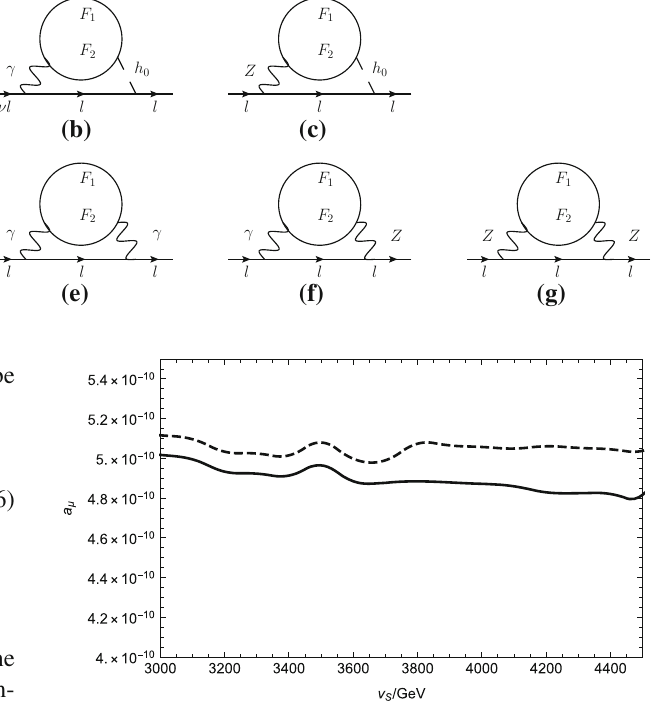
Fig. 4 a μ versus v S . The solid (dashed) line corresponds to the result with M 2 = 1000 ( 1200 ) GeV